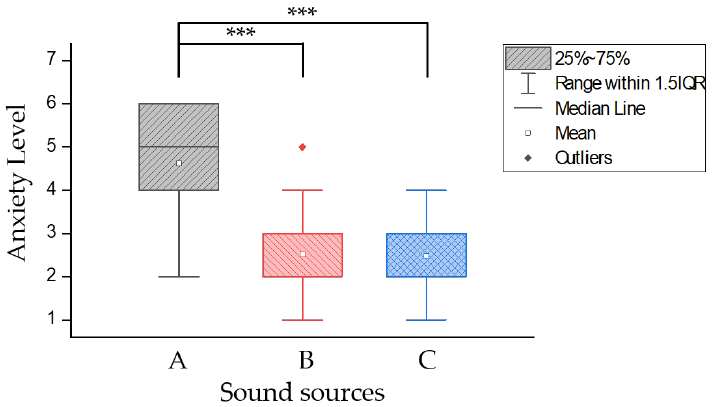
Figure 6. Subjective noise intensity results: (Source B) before applying masking technology (Source C); after applying masking technology.